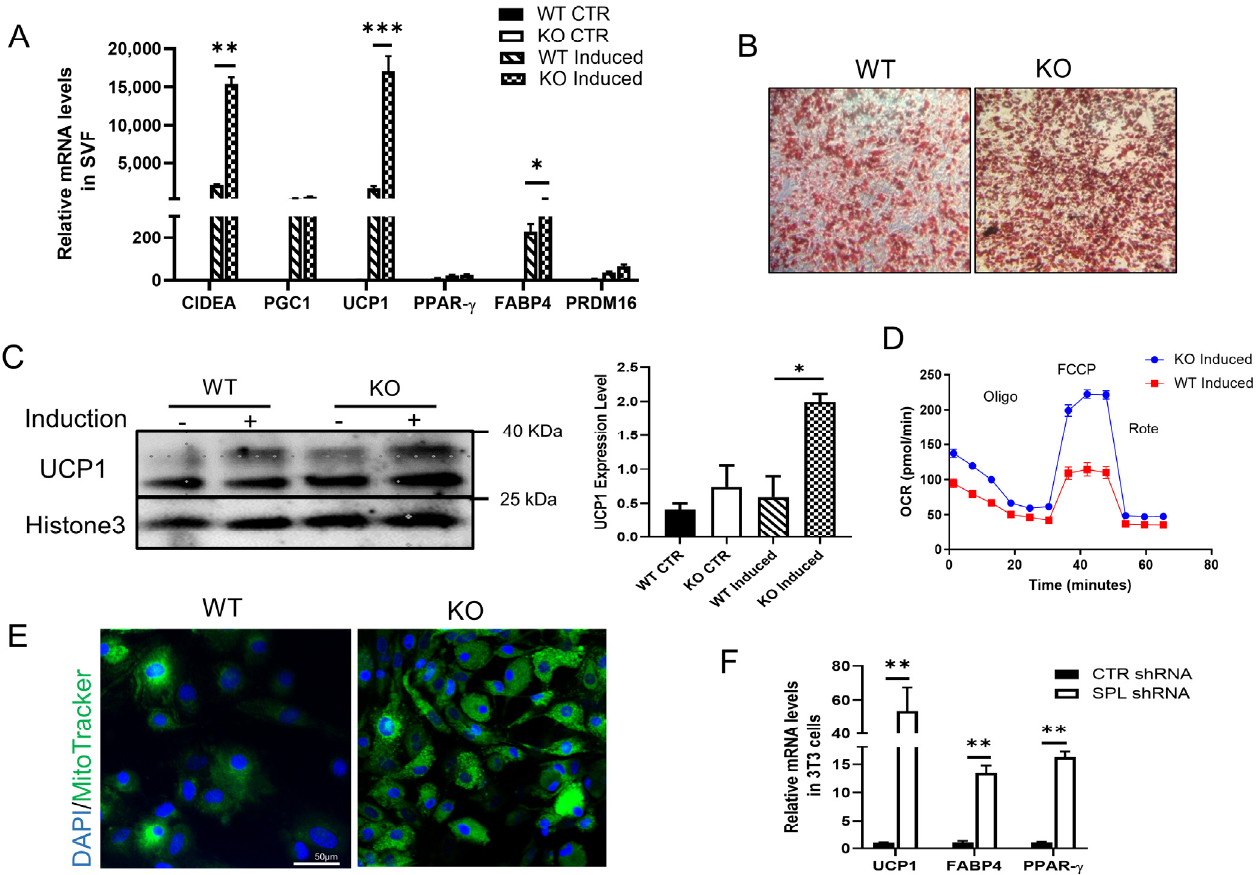
Figure 3. In vitro browning induction showed increased browning gene expression in SVF- derived adipocytes from WT and KO mice. vWAT were harvested from WT and KO mice, cultured, and treated with a full browning induction medium to induce browning, and expression of markers was measured. ( A ) mRNA expression of CIDEA, PGC1, UCP1, PPAR- γ , and FABP4 relative to beta-actin in SPL KO and WT adipocytes. ( B ) Oil-red staining of SVF after full browning induced. ( C ) UCP1 protein expression level in vWAT cells from WT or KO mice after full browning induced. Relative protein expression of UCP1 compared to the expression of Histone 3 in vWAT induced. function after browning induction. ( F ) Relative mRNA levels of UCP1, FABP4, and PPAR- γ in control or SPL shRNA transfected 3T3L1 cells after browning induction. Data were from at least three individual experiments. Two-way ANOVA with Tukey-Kramer post hoc test was used to compare the difference in ( A , C ). Unpaired Student’s t -test was performed to compare the difference between WT and KO in (F). * p < 0.05, ** p < 0.01, and *** p < 0.001. All data are presented as means ± SEM.